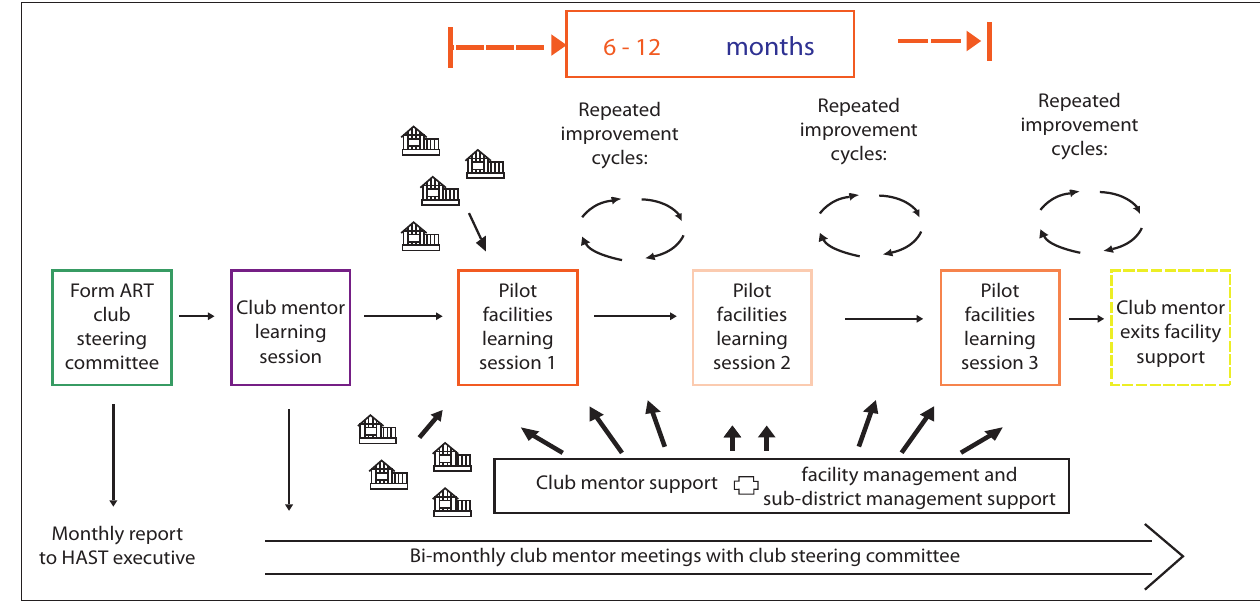
Fig. 1. Schema for the implementation of ART adherence clubs. HAST = HIV/AIDS, sexually transmitted infections (STIs) and tuberculosis